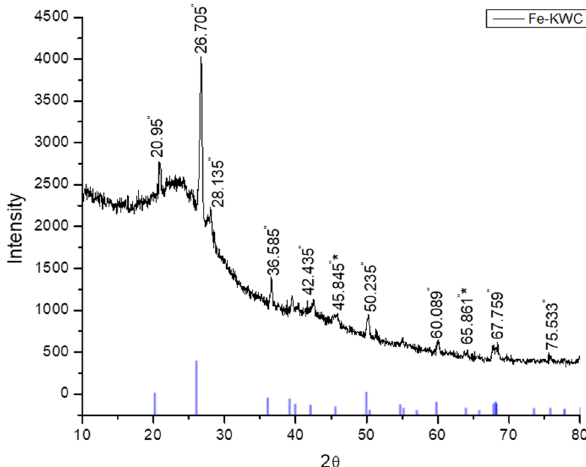
Fig. 4 Fe-KWC powder XRD spectra, showing matching with Quartz JCDP 98–008-3849 (blue spark lines and “) and zero-valent iron (*)